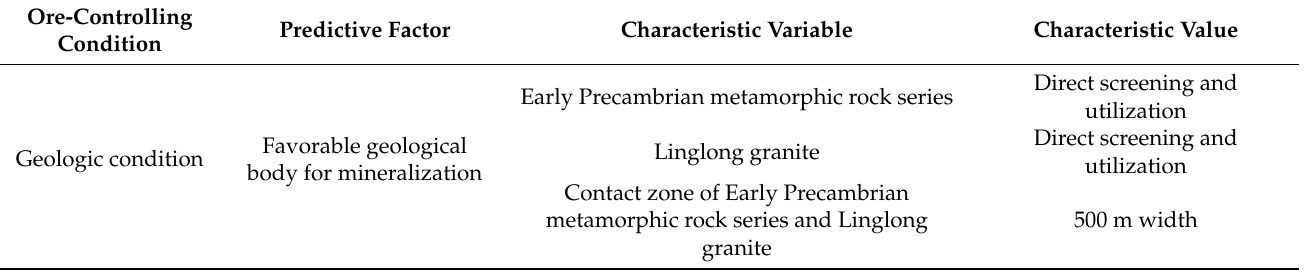
Table 3. Deep predictive model of the Sanshandao